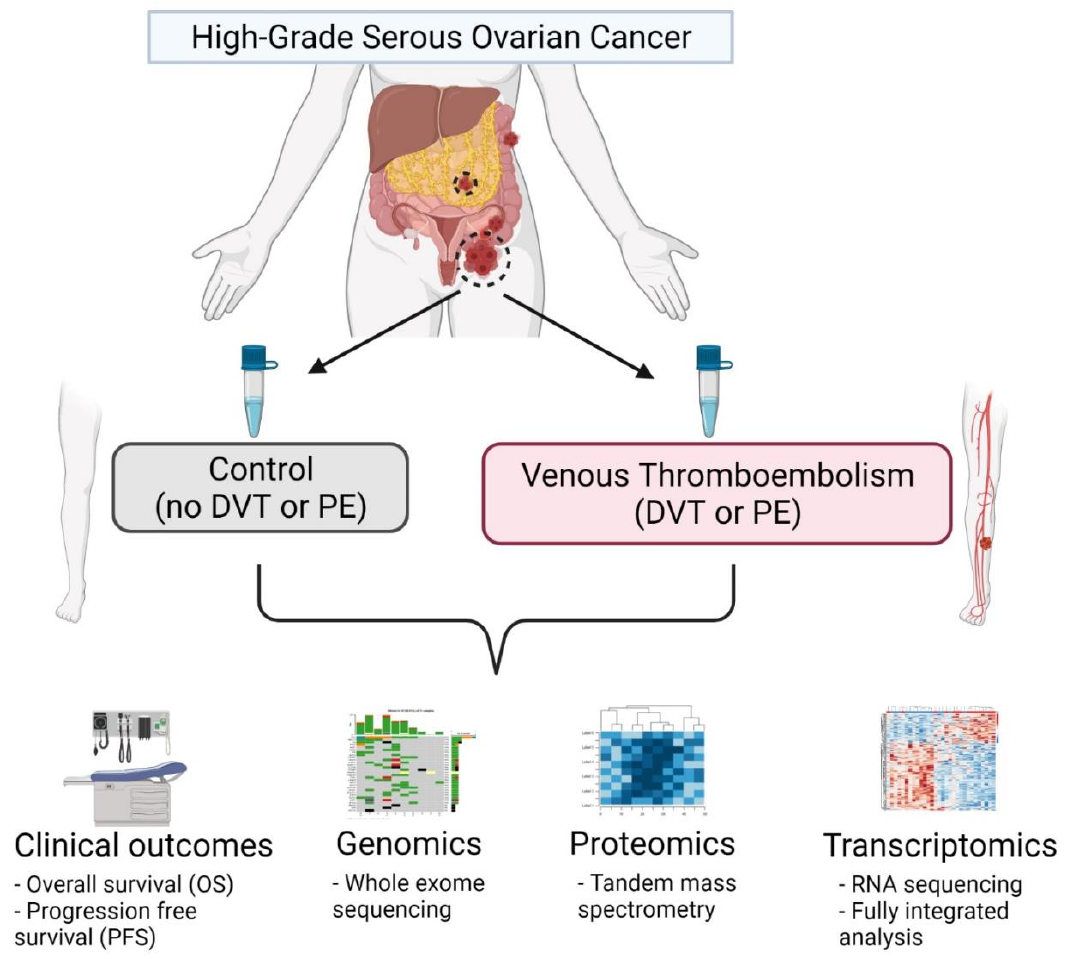
Figure 1. Schema of multi-omics analysis in HGSC patients with and without concurrent VTE. In this analysis, a total of 32 samples ( n = 16 for both control and VTE groups) were obtained from the MD Anderson Cancer Center Ovarian Cancer Moon Shot database and subjected to a multi-platform omics analysis including whole exome sequencing (WES), quantitative mass spectrometry-based proteomics, and transcriptomics with RNA sequencing and a full integrated analysis incorporating clinical data and outcomes from the electronic medical record. Figure created with